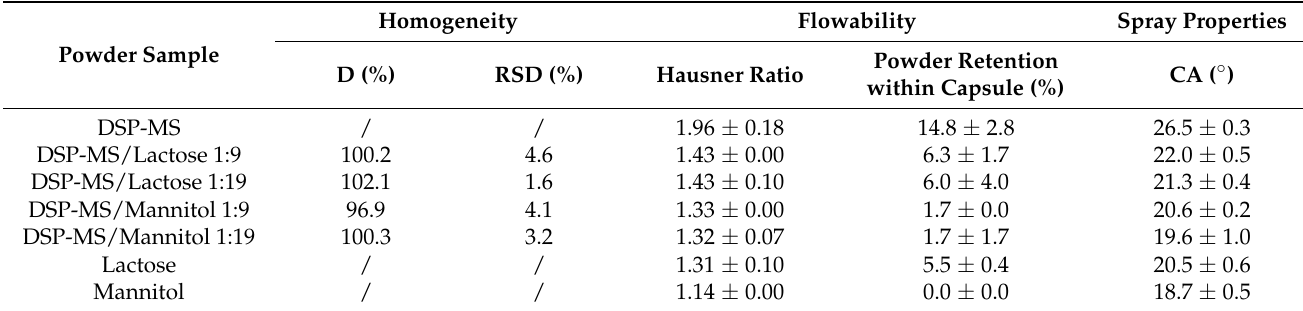
Table 2. Properties of powder blends prepared with DSP-loaded microspheres (DSP-MS) and inert carrier (lactose or mannitol) at weight ratios of 1:9 and 1:19.